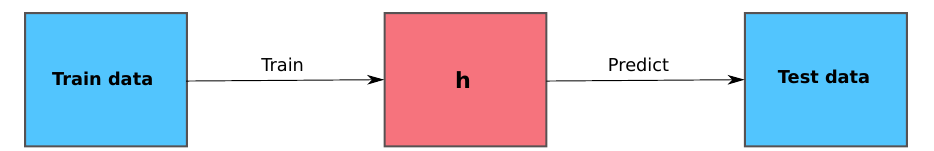
Figure 4. Traditional scheme when evaluating a non-incremental algorithm in batch processing mode.